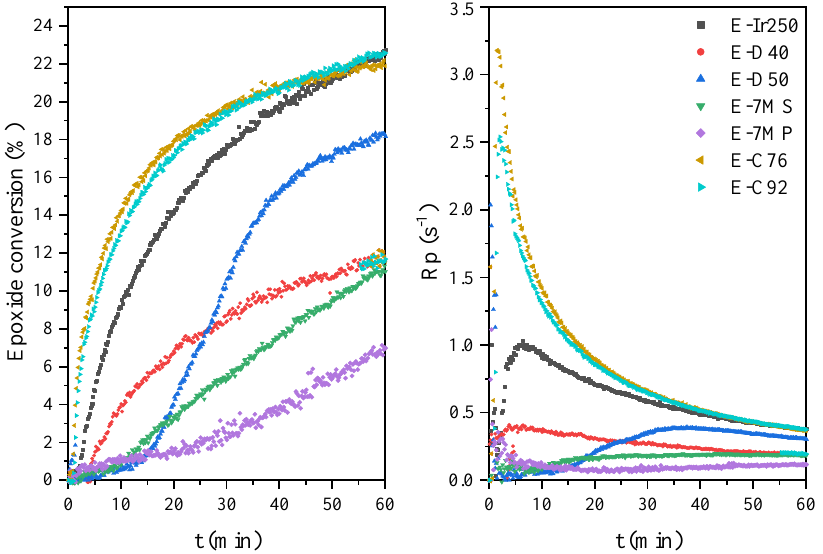
Figure 9. The epoxide conversion and photopolymerization rate curves of the epoxide resin formula- tions with cationic photoinitiators.